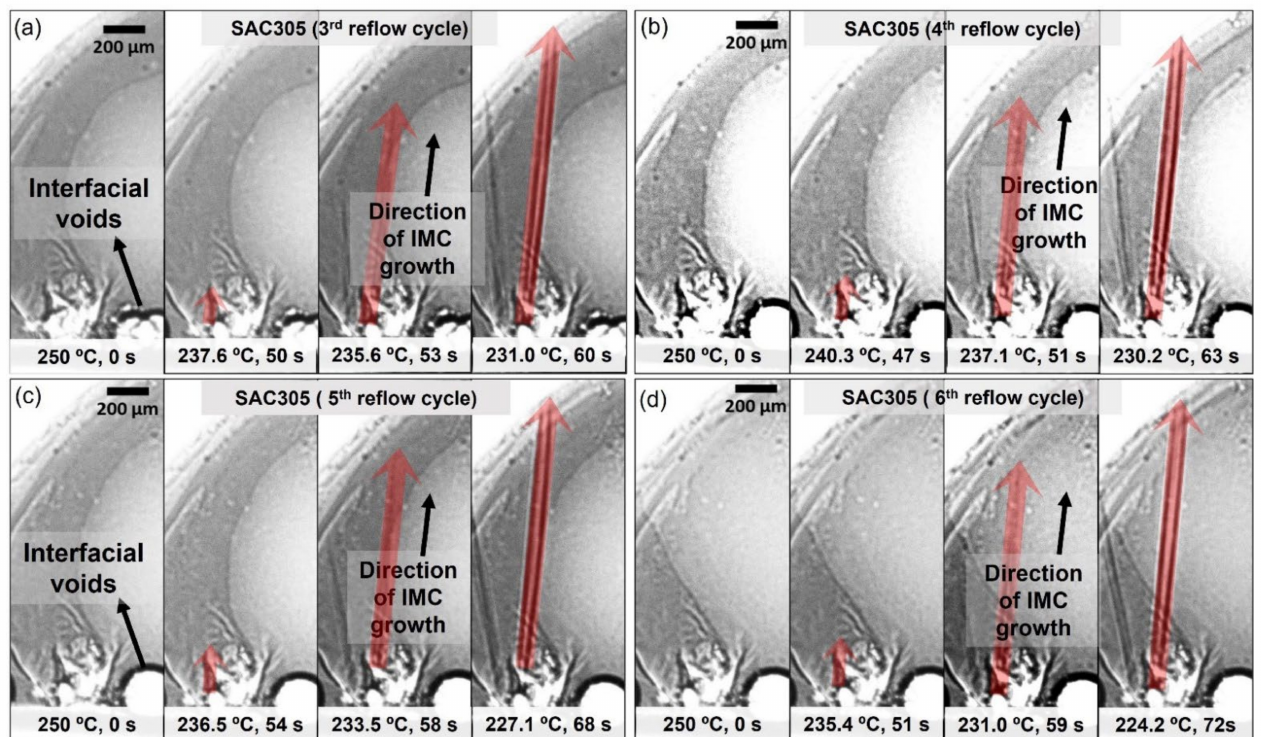
Figure 8. Sequences of the image showing the growth of IMC (denoted by ‘g’) in SAC305 solder joints during ( a ) 3rd reflow cycle, ( b ) 4th reflow cycle, ( c ) 5th reflow cycle, and ( d ) 6th reflow cycle (t = 0 s when the sample begins to